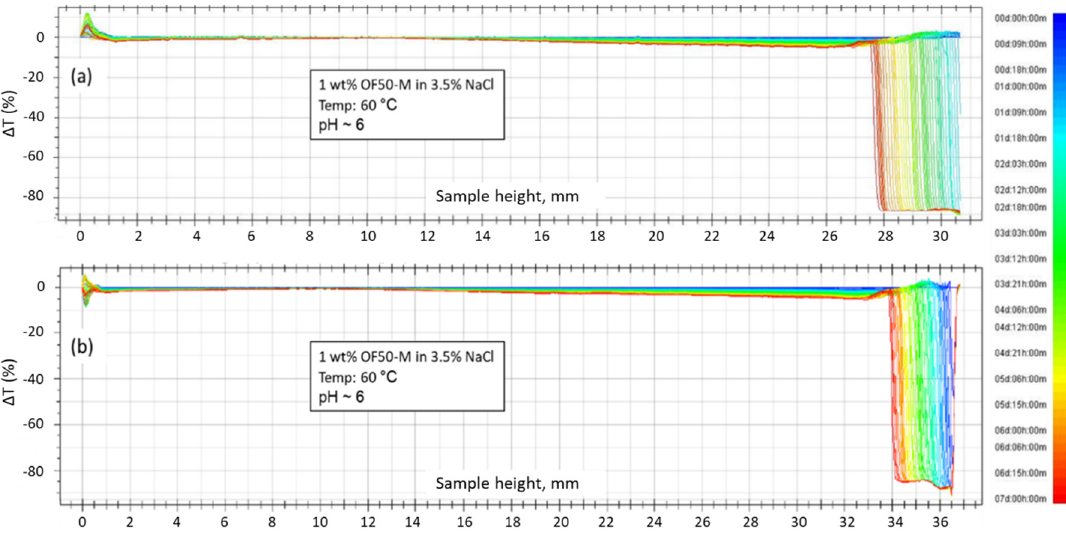
Figure 6. Transmission ( Δ T) profiles obtained by Turbiscan TM at 60 °C for 1 wt.% OF50-M nanoparticles in ( a ) SSW and ( b ) 3.5% NaCl brine for 1-week duration. ( b ) 3.5% NaCl brine for 1-week